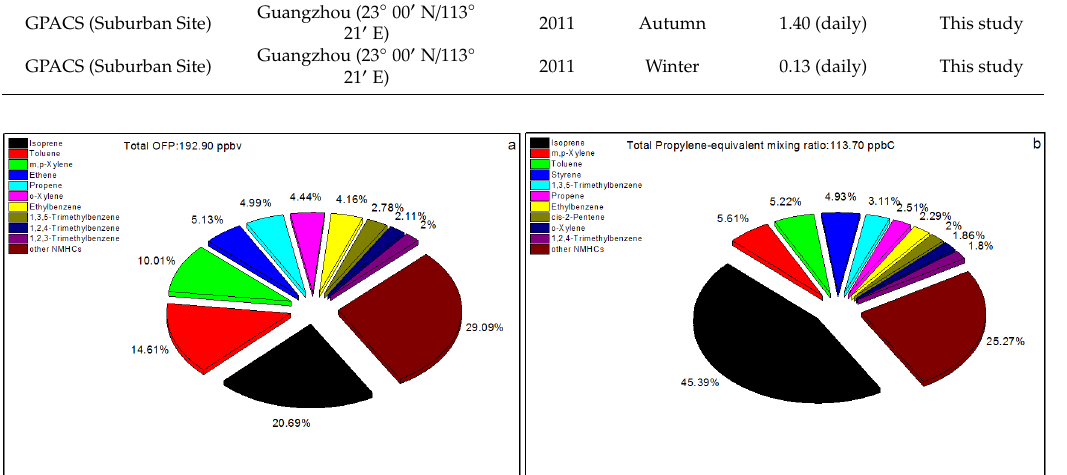
Figure 3. Fractional contribution of NMHCs to total OFP (O 3 formation potential) ( a ) and total propylene-equivalent mixing ratio ( b ) during photochemical reaction process (10:00–17:00 LT) from June 2011 to May 2012 at GPACS.